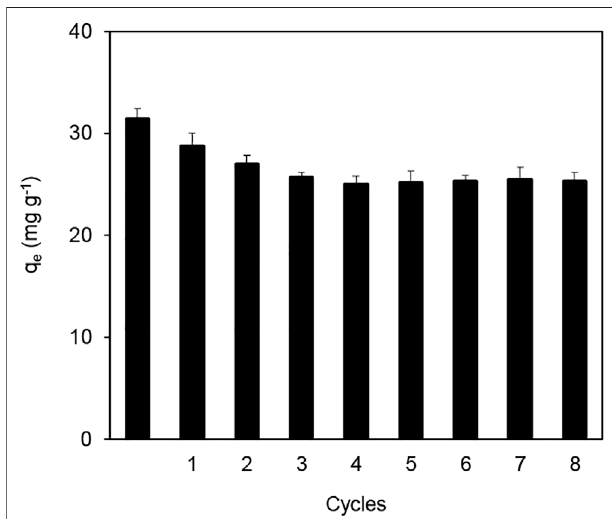
FIGURE 10 | Pb(II) adsorption by virgin and regenerated Fe 3 O 4 @SiO 2 - MnO 2 (1.54) adsorbent within eight adsorption-desorption cycles. (C 0 (Pb(II) = 25.0 mg L − 1 , adsorbent dosage = 0.5 g L − 1 , Temperature = 25 ° C, Pb(II) adsorption pH = 4.0 ±